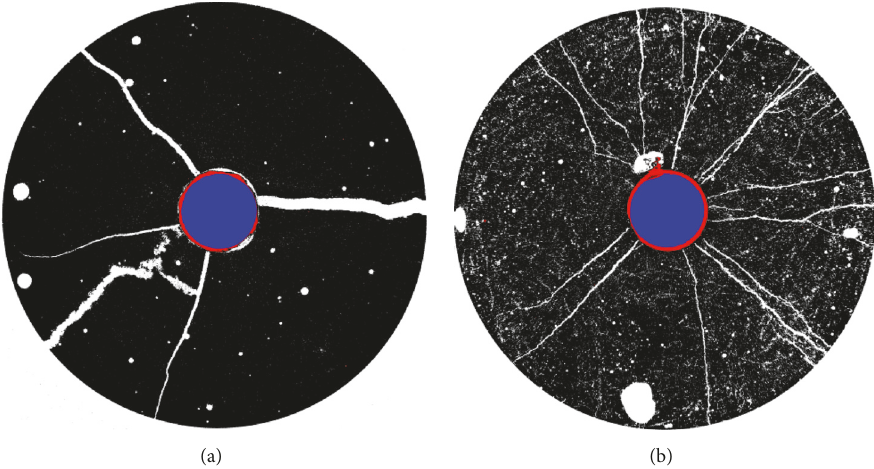
Figure 10: CT scan of corrosion induced cracking [13] in (a) plain mortar (b) SHCC. Blue colour denotes the steel rebar, red the rust layer, black the material matrix, and white voids and cracks.